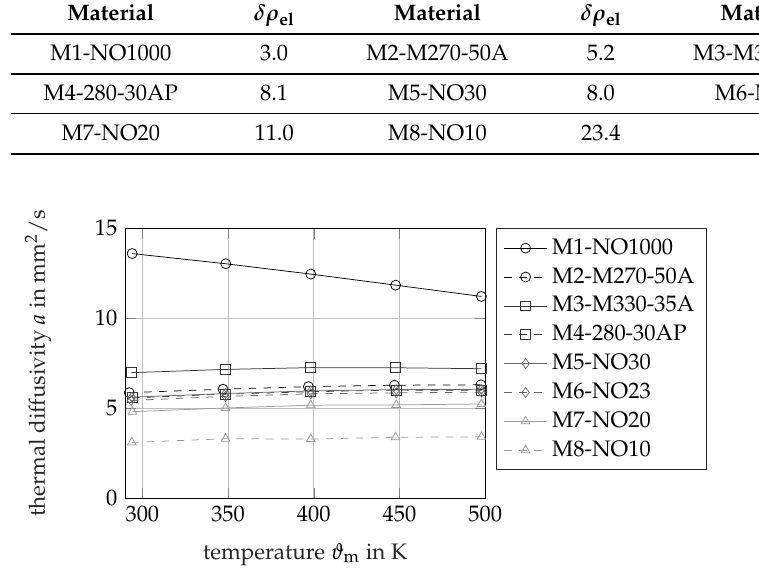
Figure 6. Results of the thermal diffusivity measurements a ( ϑ )